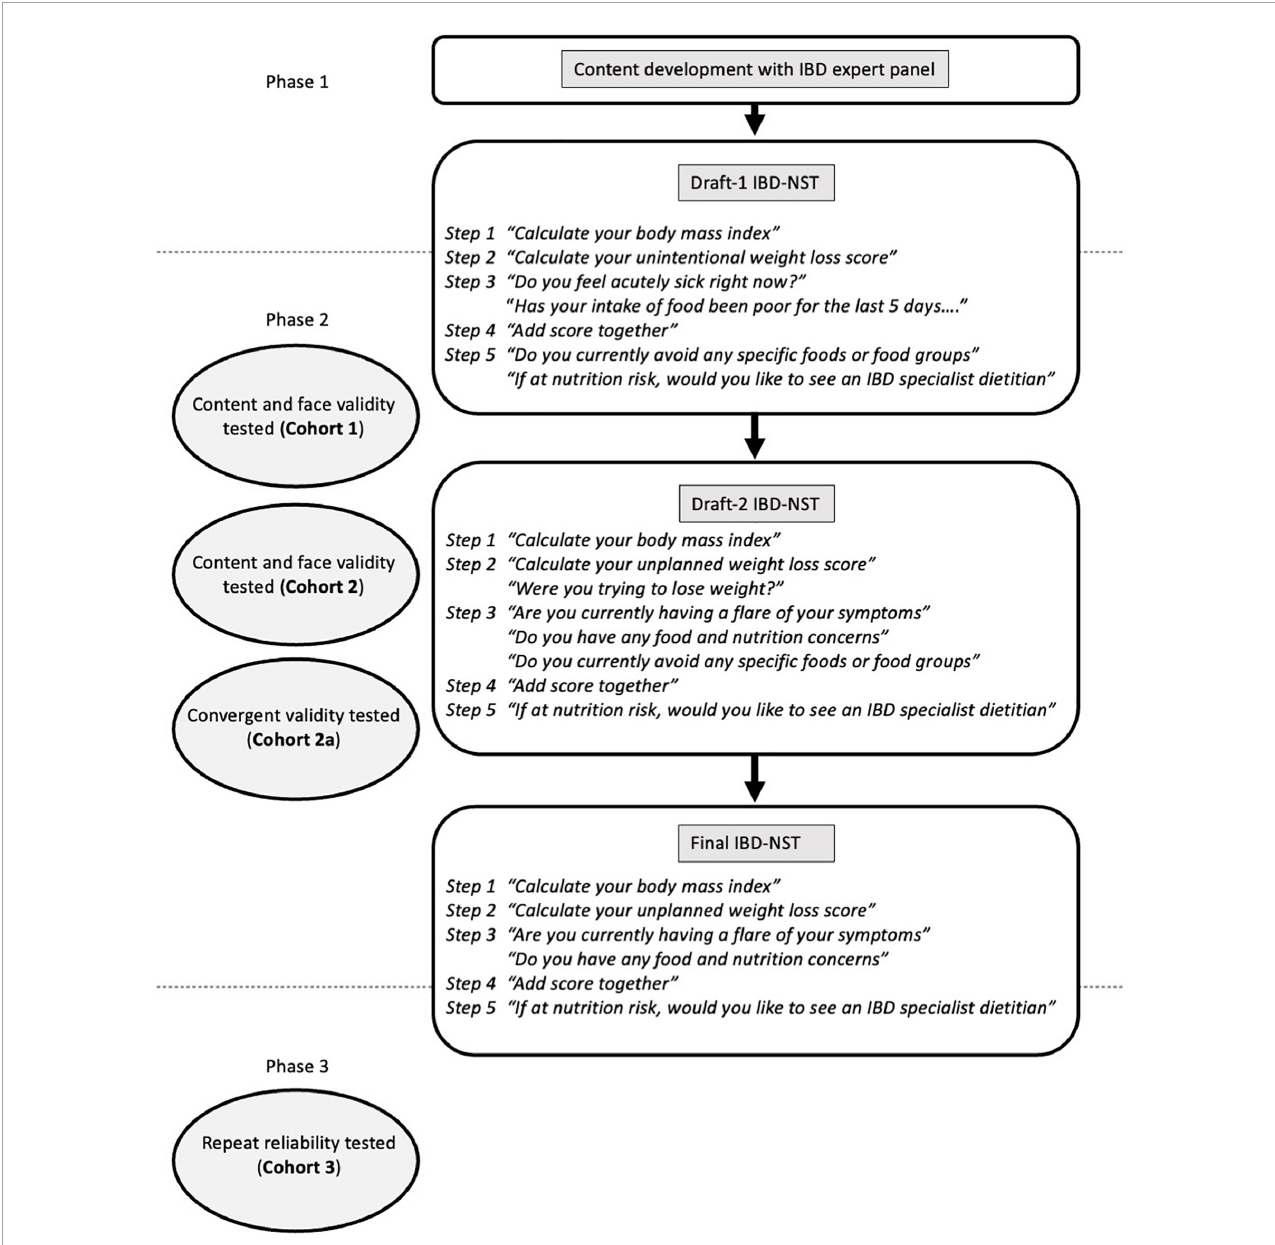
FIGURE1 Development and validation of an IBD nutrition self-screening tool (IBD-NST).